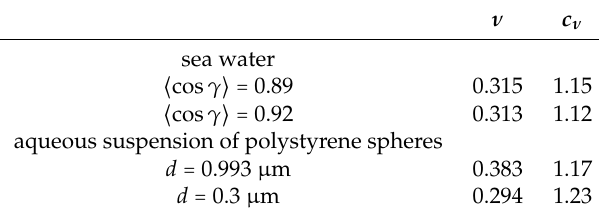
Table 1. The values of c ν and ν for sea water (Kopelevich’s model [47,48]) and its imitation.